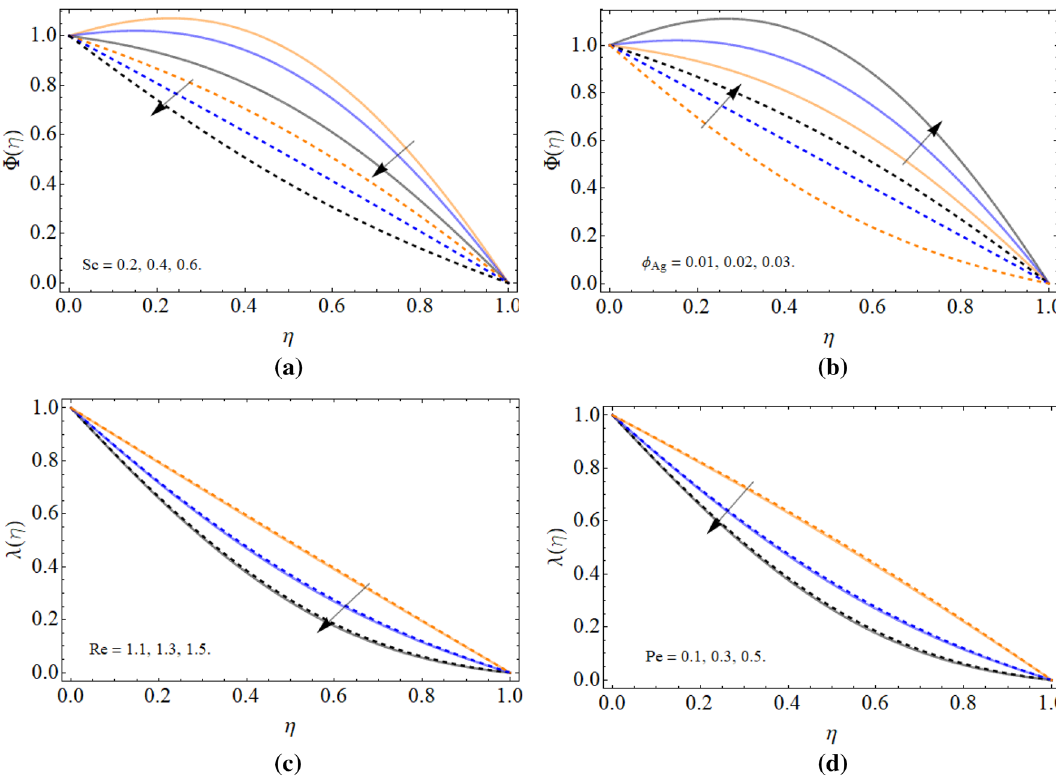
Figure 7. The behavior of mass transfer profile �(η) and motile microorganism ¯ (cid:31) (η) versus ( a ) Schmidt